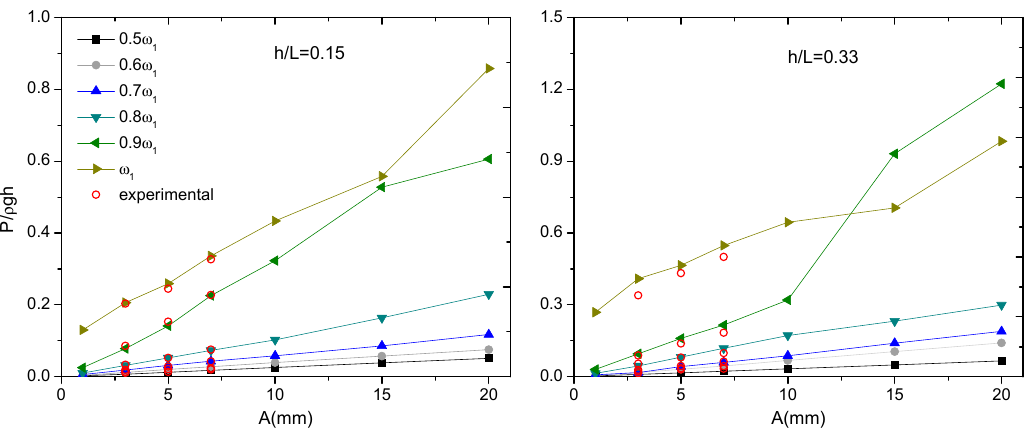
Figure 14. The amplitude–pressure response curve.